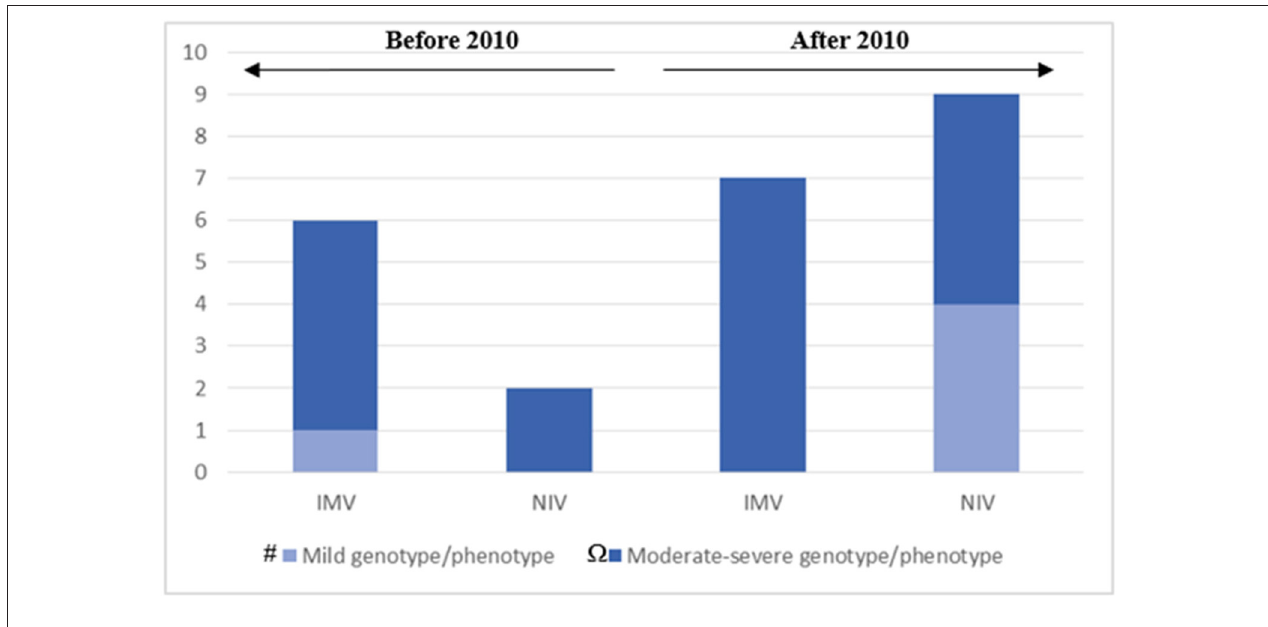
FIGURE 3 | The chart represents our clinical approach in different decades: after 2010, IMV has been reserved for patients with moderate to severe genotype/phenotype; NIV has been applied as the first choice for ventilator support in patients with mild and moderate to severe genotype/phenotype. # Mild genotype/phenotype: PARMs 20/25. Ω Moderate-severe genotype/phenotype: PARMs 20/26, 20/27; NPARMs C.225_256delCT, c.780dupT. One adult female patient that still doesn’t need ventilation is not included. One adult female patient that started NIV in adult age is included in the fourth column. The 3 patients with moderate-severe genotype/phenotype that carried out the decannulation on program are also included in the fourth